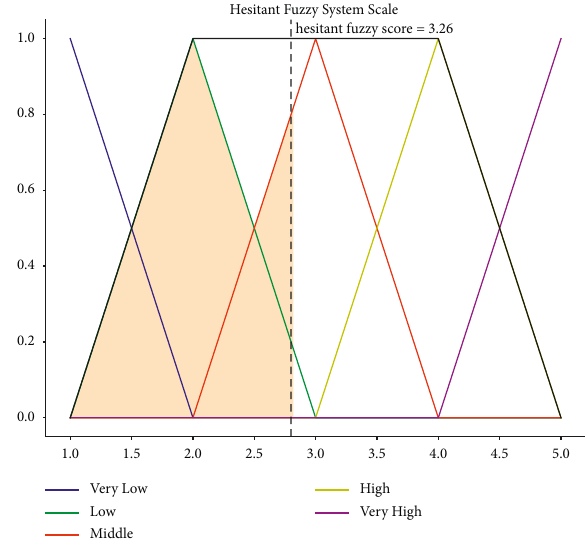
Figure 4: Hesitant-fuzzy common range